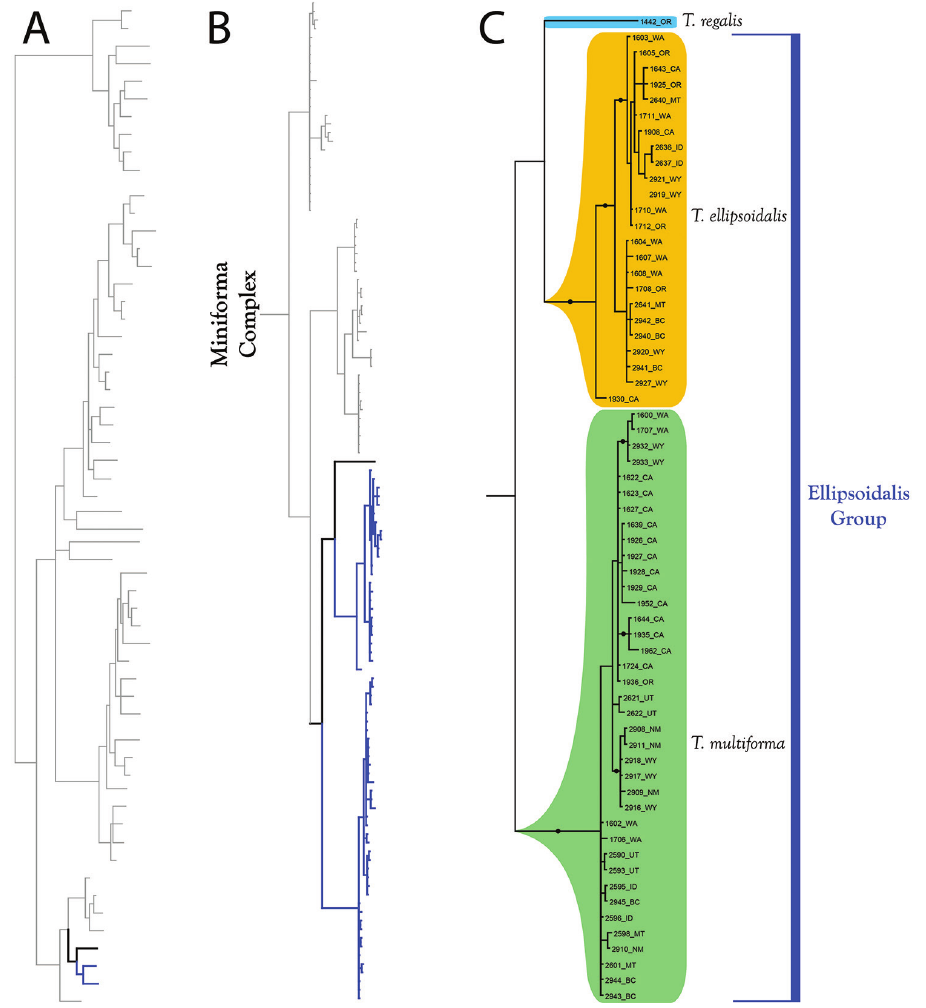
Figure 13. Miniforma Complex (part II). All species are western. One species ( T. regalis ) does not fit within a species group. Note that T. ellipsoidalis and T. multiforma are widespread in the west (C). A Spe- cies guide (overview of 28S+COI analysis from Figure 7–8) B Overview of Miniforma Complex from Figure 9 (COI-only analysis from Figure 9) C Detail of Miniforma Complex (in part) from B C Detail of Miniforma Complex (in part) from Figure 9. Colored lineages in A and B correspond to Group names and brackets in C. Dots denote posterior probably of greater than 95%. Taxa are displayed by DNA num- ber and state (U.S.) or territory (Canada)